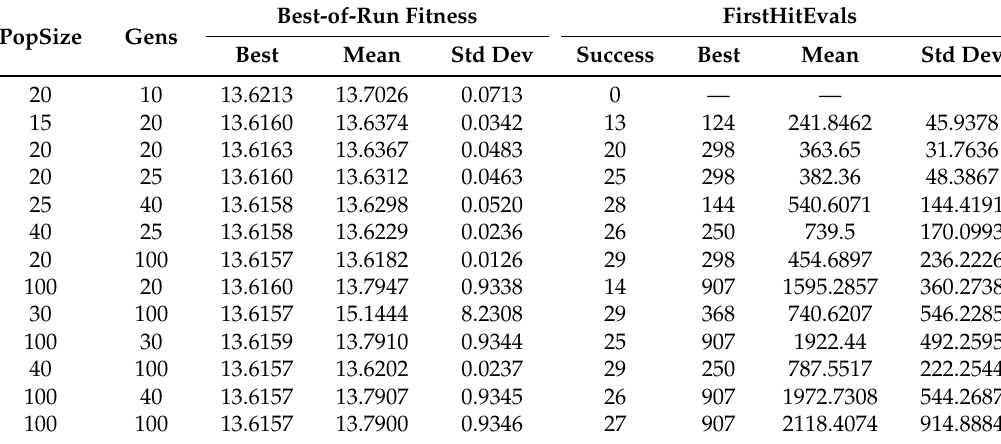
Table 9. Results of Jaya on the fuel cell problem (each row corresponds to 30 independent runs). Most numbers are shown with rounding at the fourth place after the